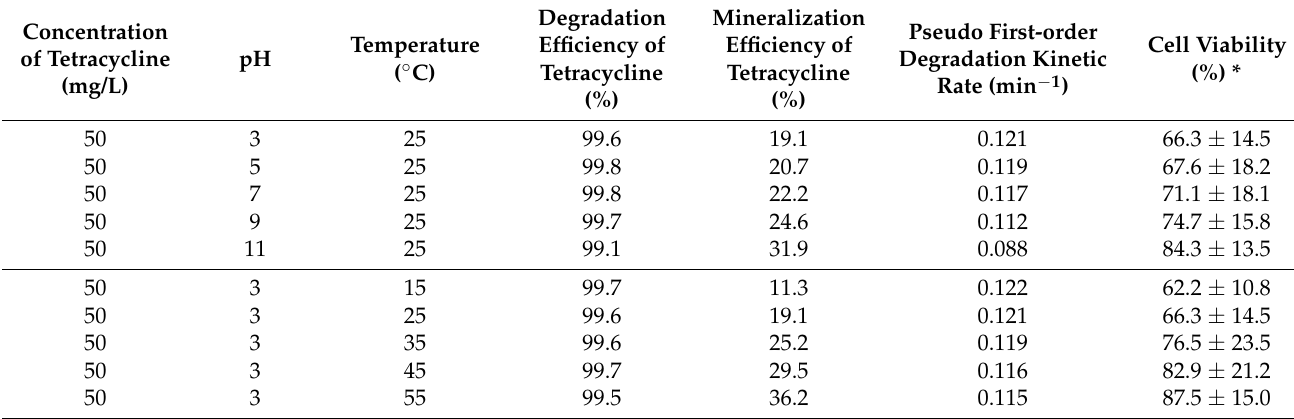
Table 1. Degradation and mineralization of tetracycline by ultrafine-bubble ozonation at different reaction pH and